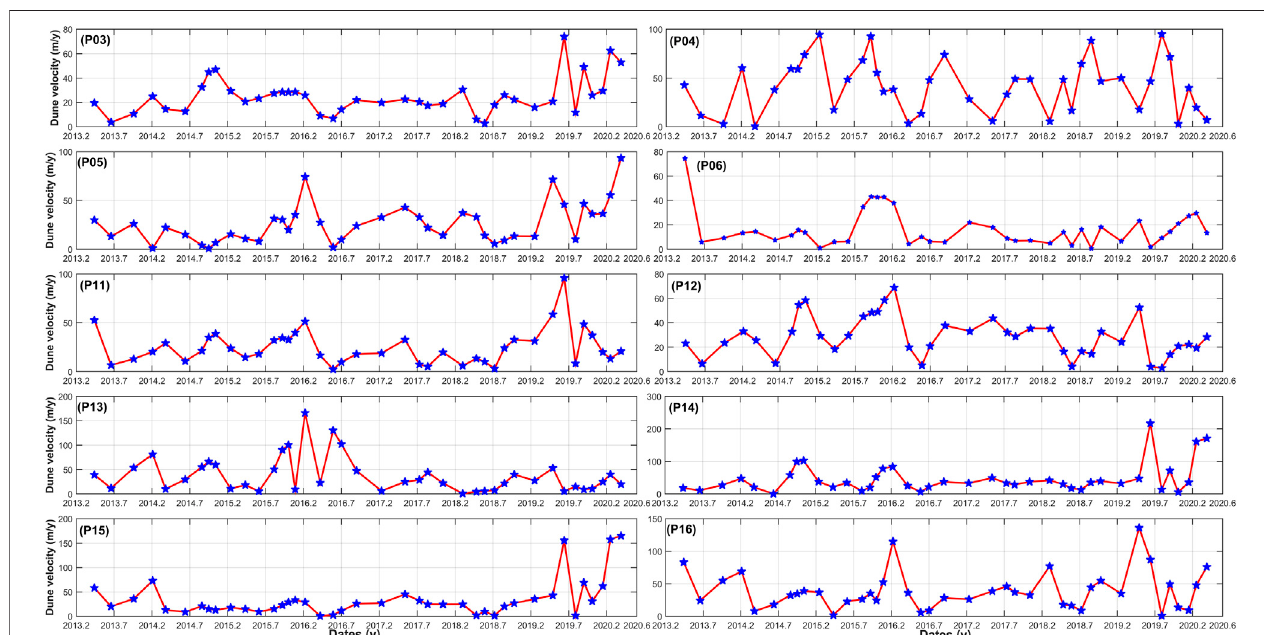
FIGURE 10 | Time series of dune velocities as extracted from the inversion of offset maps belong to Landsat-8 frame 183/48. The blue pentagrams represent the acquisition epochs. The red lines denote the continuous dune velocities.